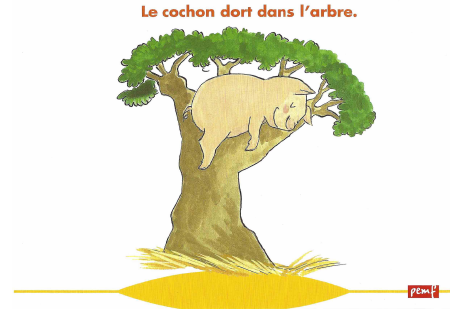
Figure 3. Example of a reading worksheet intended for personal work in autonomy in level of first year of primary school (edition PEMF& Cie).